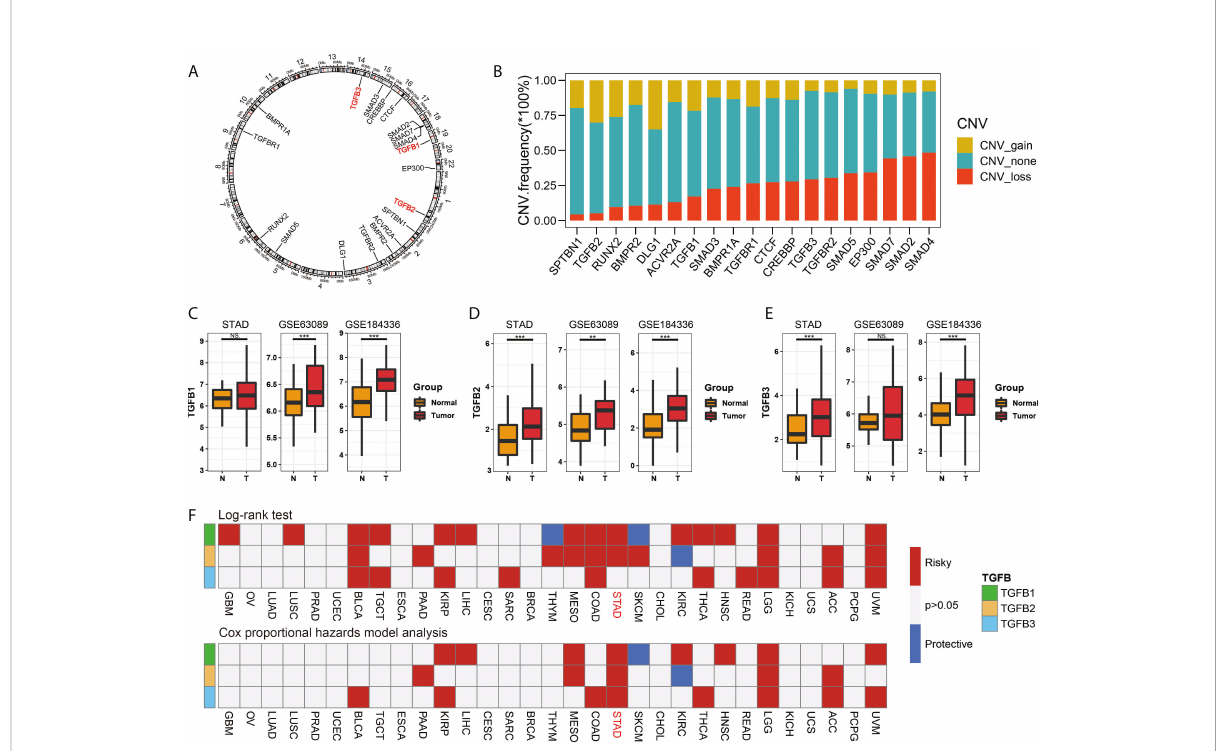
FIGURE 1 TGF b gene characteristics. The chromosomal location of the TGF b gene family and related genes (A) , and compared the copy number changes (gain, none and loss) of different genes (B) . Comparison of expression levels of TGF b 1, TGF b 2 and TGF b 3 in cancer and paracancerous tissues in STAD, GSE63089 and GSE184336 data sets (C – E) . Cox univariate analysis and Kaplan Meier survival analysis of TGF b 1, TGF b 2 and TGF b 3 in pan – cancer (F) . * P < 0.05; ** P < 0.01; *** P < 0.001; ns, no signi fi